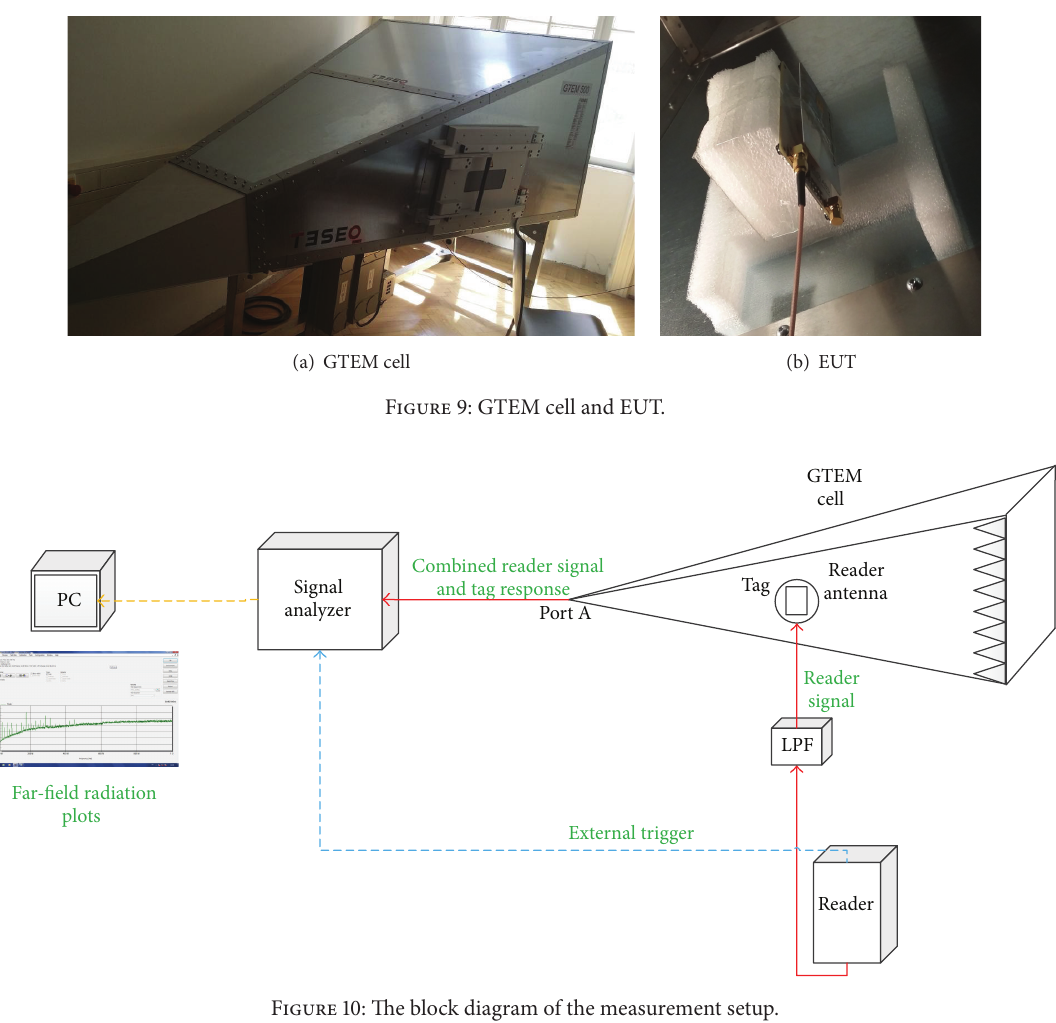
Figure 10: The block diagram of the measurement setup.